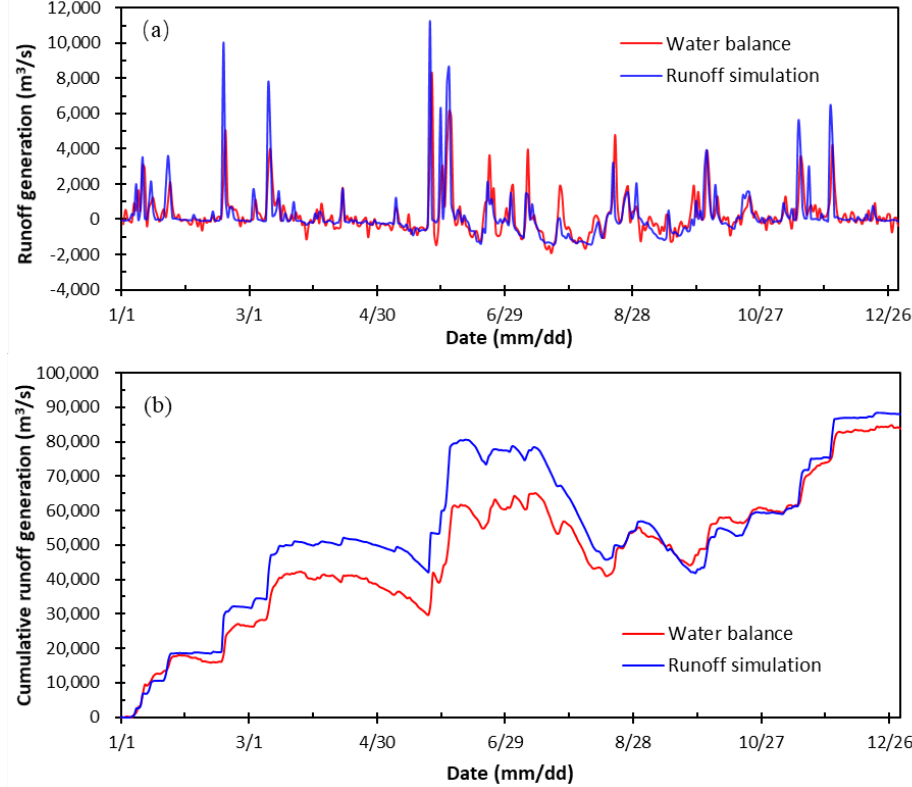
Figure 8. Time series and cumulative of runoff for the whole Taihu Basin in